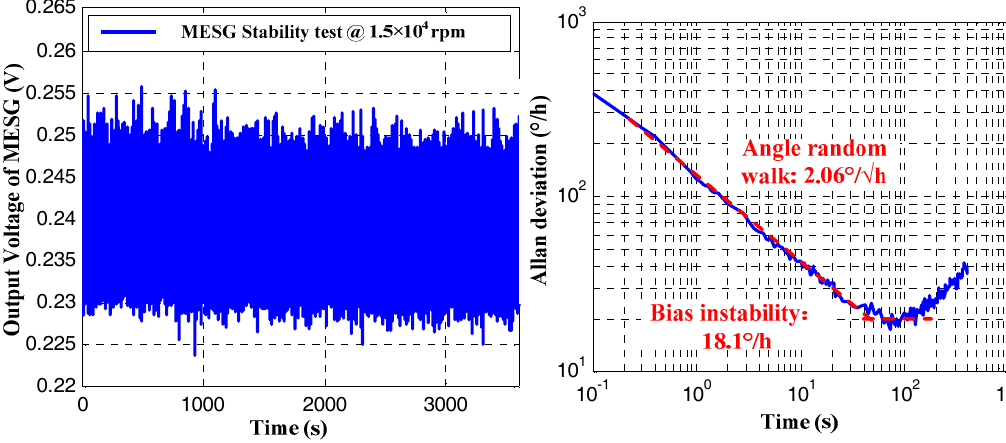
Figure 9. Gyroscope output in time domain and its Allan deviation at spin rate of 1.5 × 10 4 rpm.